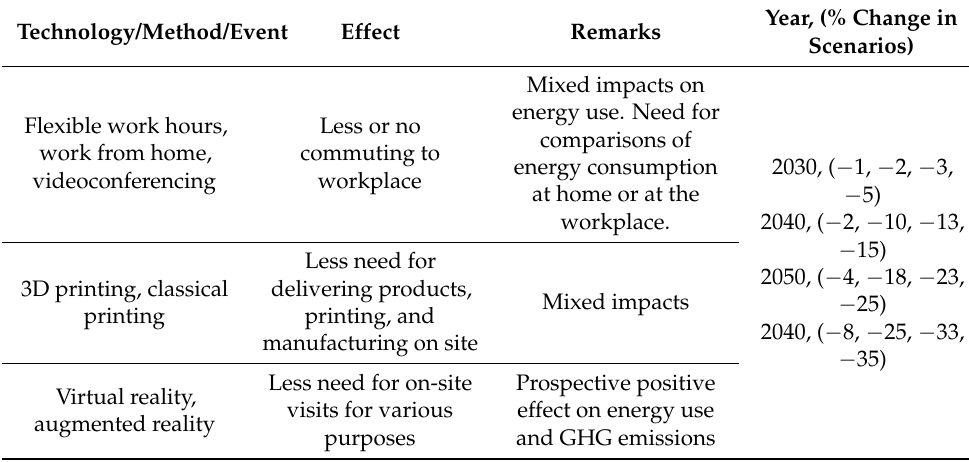
Table 7. New technologies affecting road transportation needs